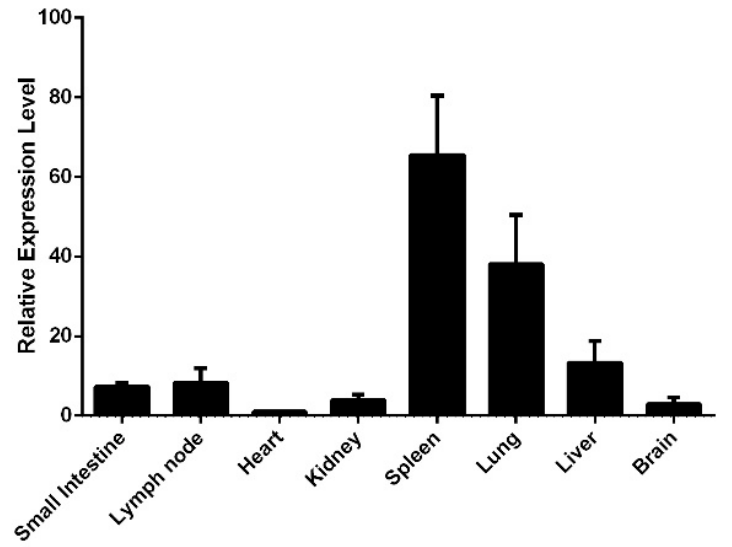
Figure 1. Distribution of canine RIG-I gene in different tissues of beagle dog. The expression level of canine RIG-I gene in each tissue is normalized by glyceraldehyde 3-phosphate dehydrogenase (GAPDH) mRNA and the heart tissue serves as a control. Samples were analyzed in triplicate and 3 independent experiments were performed. Error bars indicate standard deviations.